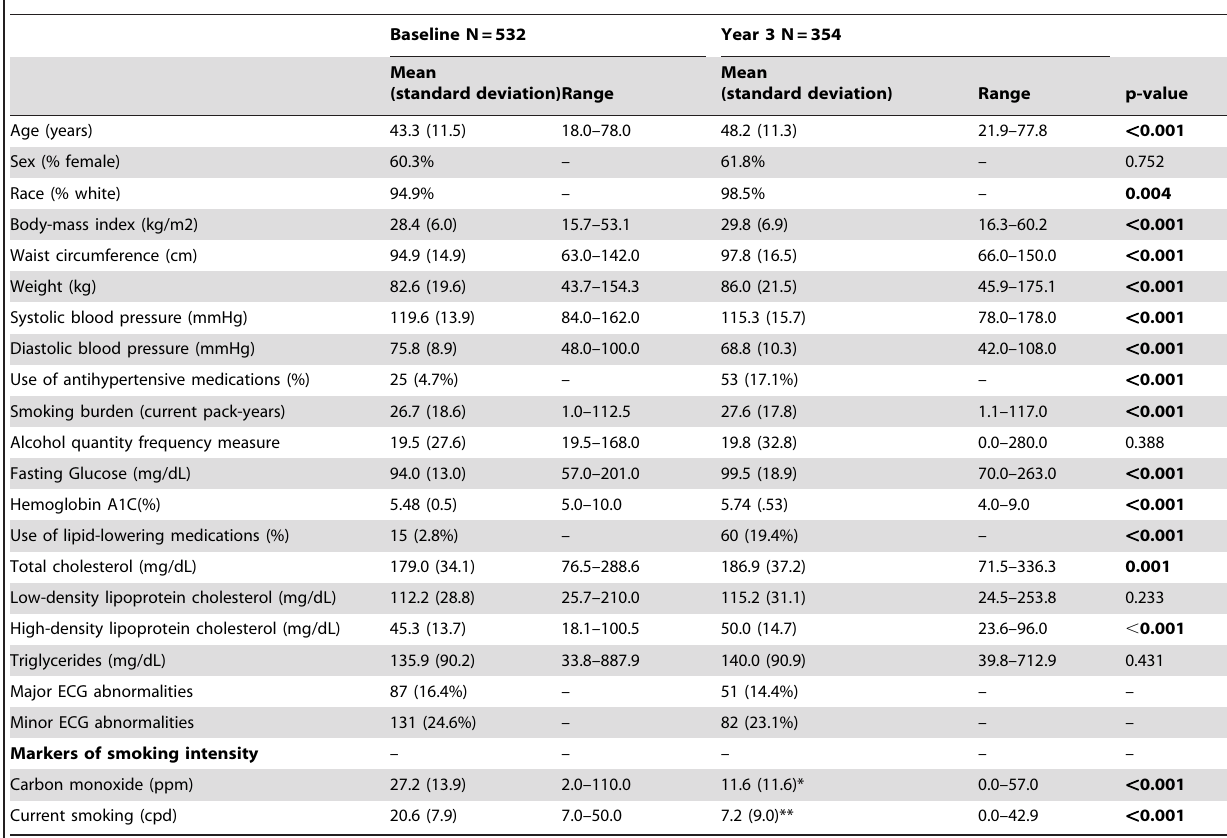
Table 1. Subject Characteristics at Baseline and Year